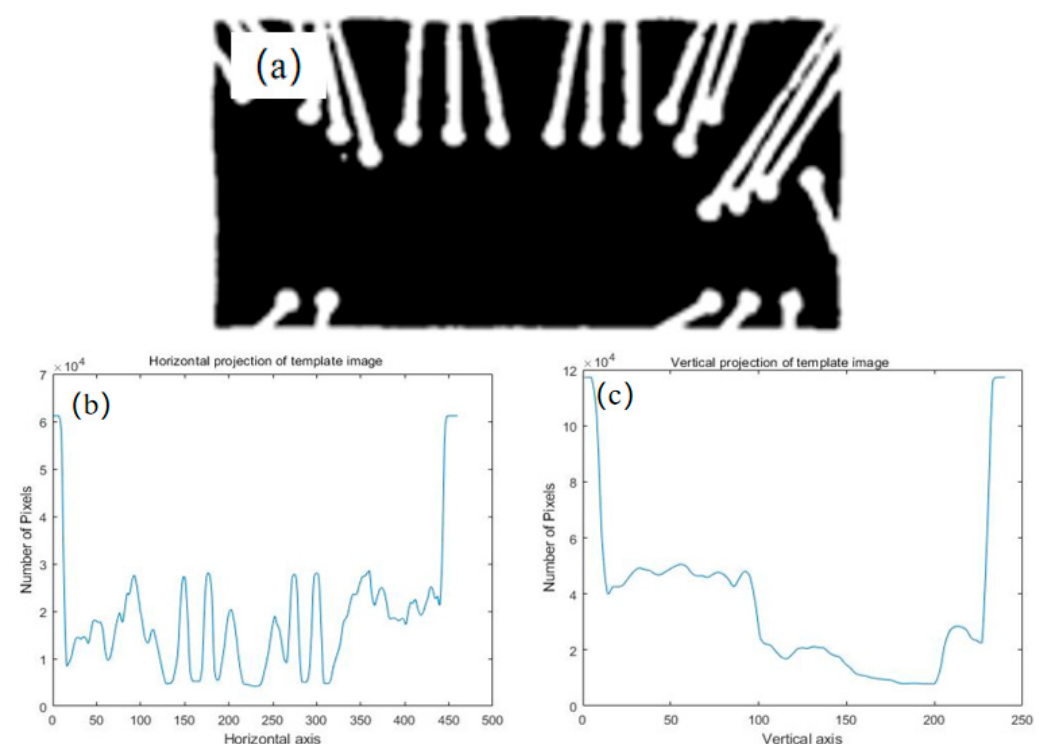
Figure 8. Binary image of template and its projection. ( a ) Binary image, ( b ) vertical projection, and ( c ) horizontal projection of template.